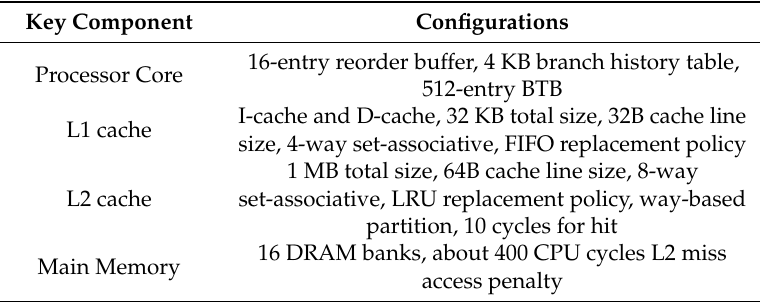
Table 3. Key Component Configurations on the FPGA